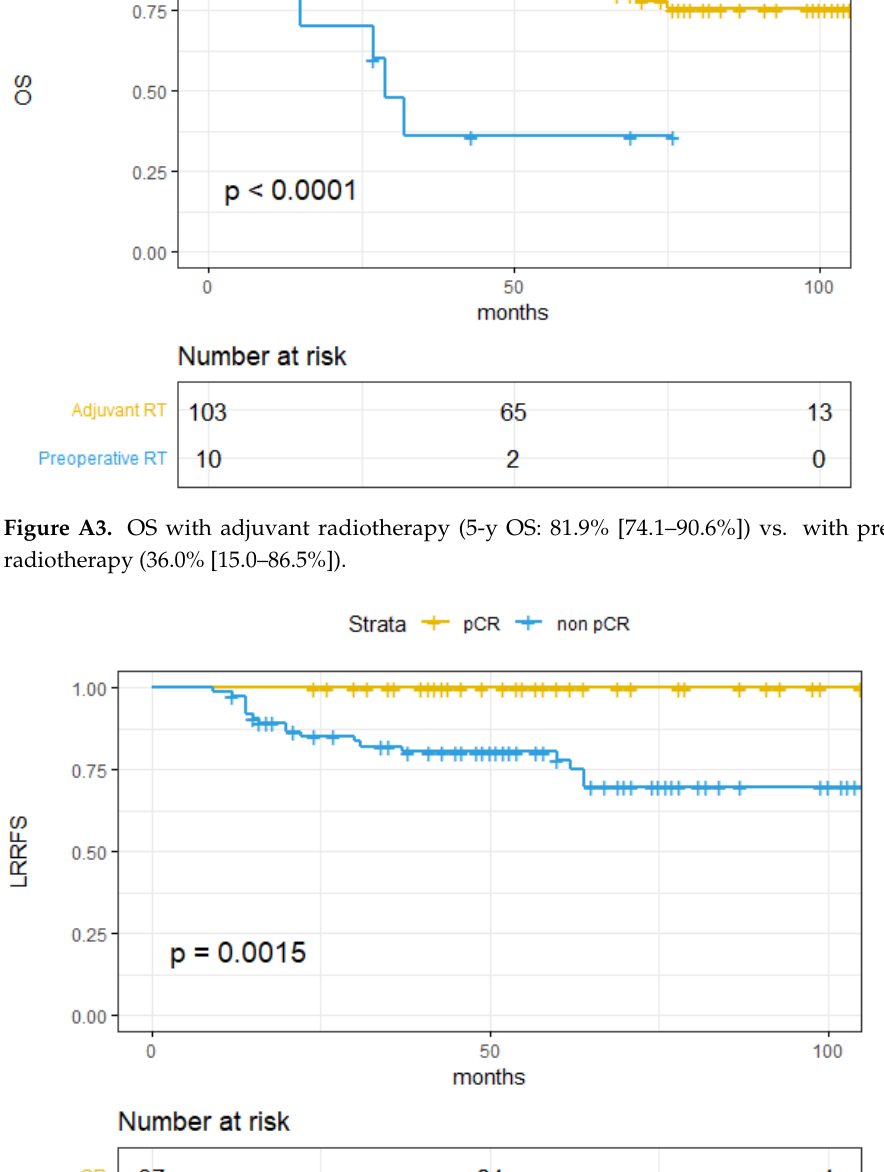
Figure A4. LRRFS in patients achieving pCR (5-y LRRFS: 100% [100–100%]) and those not achieving pCR (77.9% [68.3–88.8%]).